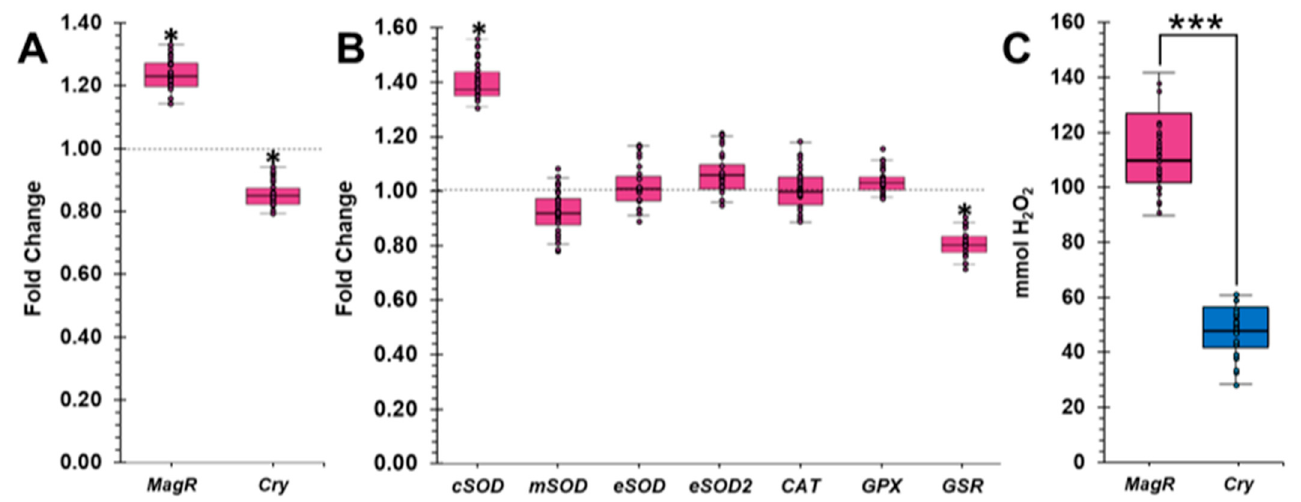
Figure 7. Effect of GMF on the gene expression of MagR and Cry ( A ), SOD, CAT, GPx, and GSR ( B ), or H 2 O 2 content ( C ) of Lasius niger . For Panels A and B, Gene expression is expressed as fold change calculated as the GMF/NNMF ratio (N = 30). The dotted line represents the gene expression under NNMF condition, while bars represent the mean ± SD of three qRT-PCR biological replicates carried out in triplicate. For all panels, within each box the horizontal black lines indicate median values, while boxes extend from the 25th to the 75th percentile of the distribution of values in each group (N = 30). The extended vertical lines indicate the standard deviations. Asterisks indicate significant (* p < 0.05; *** p < 0.001) differences.